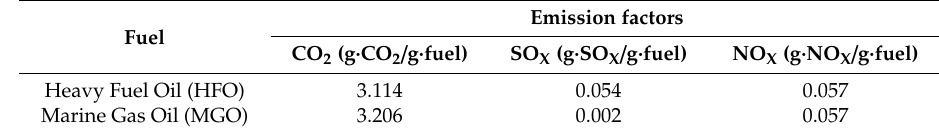
Table 12. Emission factors for different pollutant types.